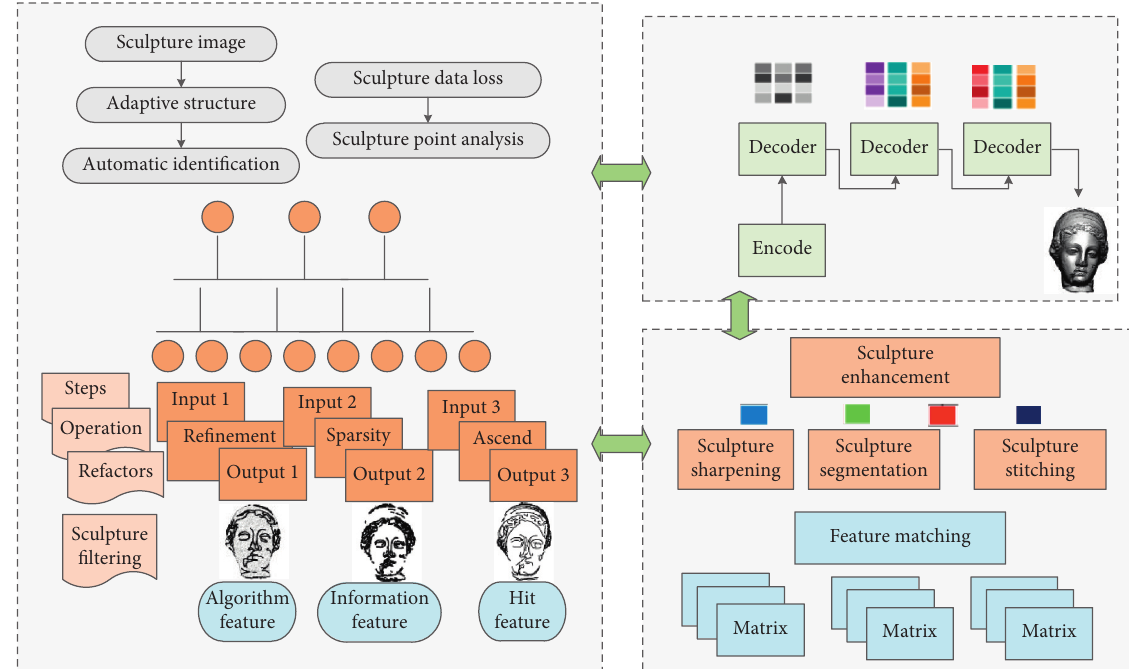
Figure 4: Sculpture 3D model hierarchy based on image sequence.